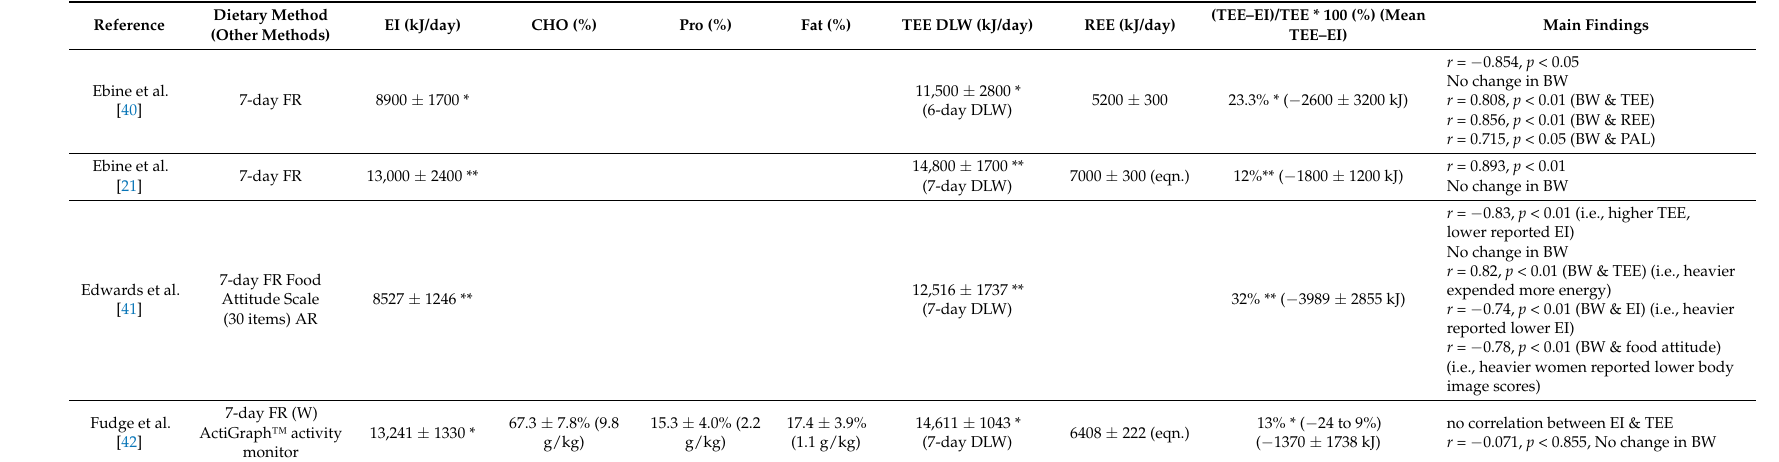
Table 2. Key findings from studies comparing reported energy intake to energy expenditure measured by